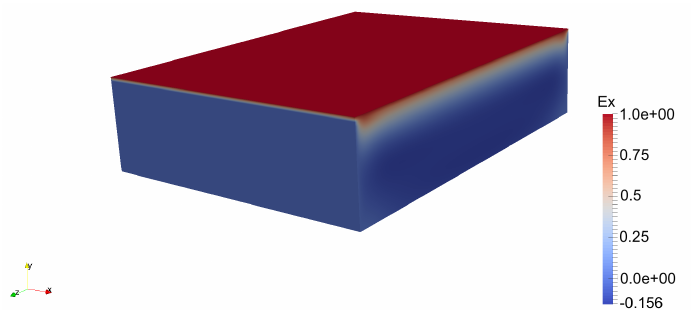
Figure 11. Simulated electric field when the incident field is polarized in the normal direction with respect to the fibers for ω 1 = 2.45 GHz.